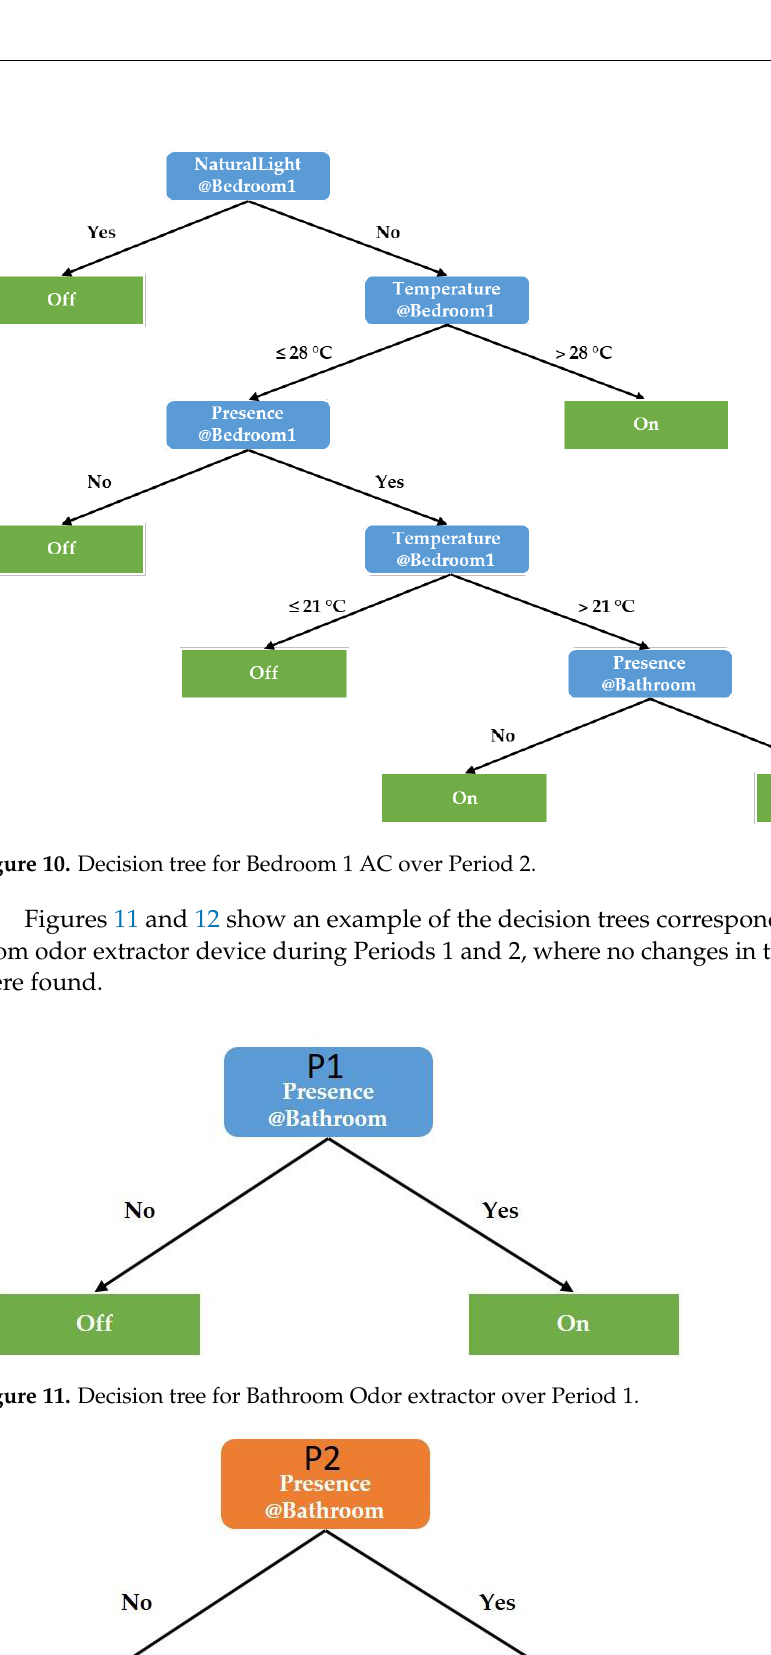
Figure 9. Decision tree for Bedroom 1 AC over Period 1.